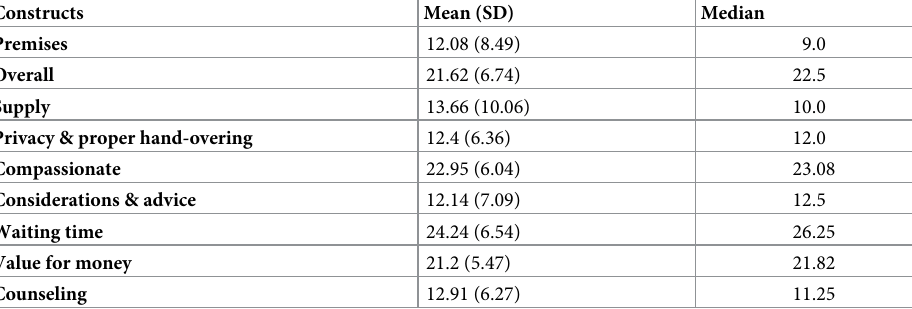
Table 4. Descriptive statistics of satisfaction constructs (after rescaled), December